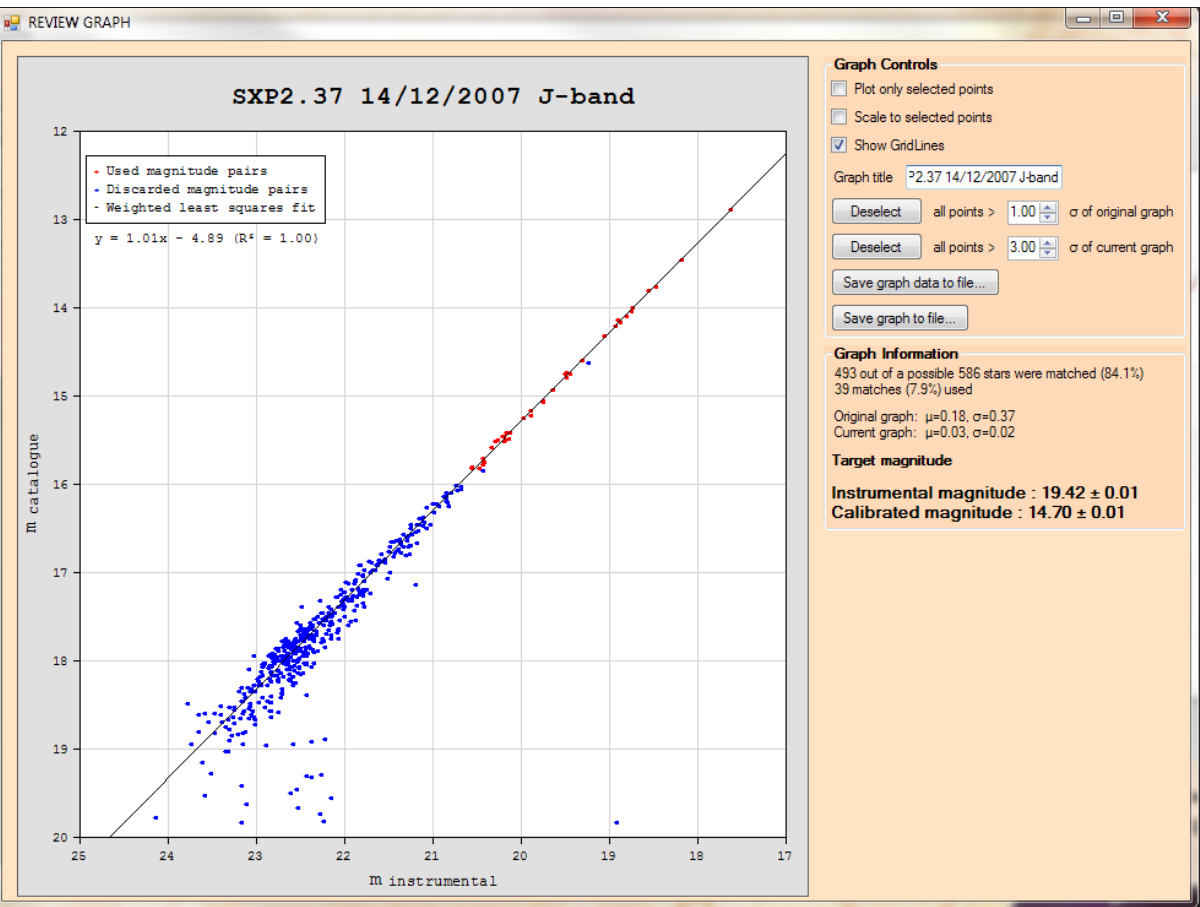
Figure 1: Calibration graph for the J-band observation of SXP2.37 on 14 December